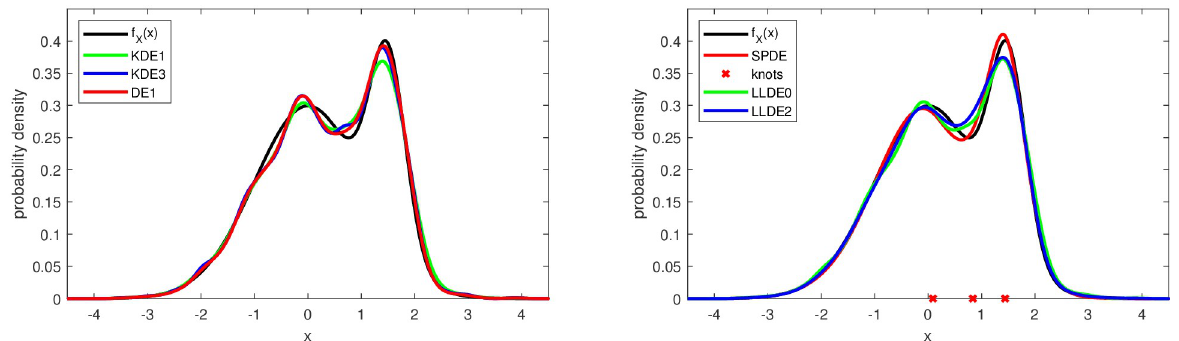
Fig 2. Test case 6: Example of density estimates obtained from the kernel density and diffusion estimators (left) as well as from the semiparametric and local likelihood estimators (right). The SPDE is the model SPL2 with 3 knots after knot deletion. The sample size is N =